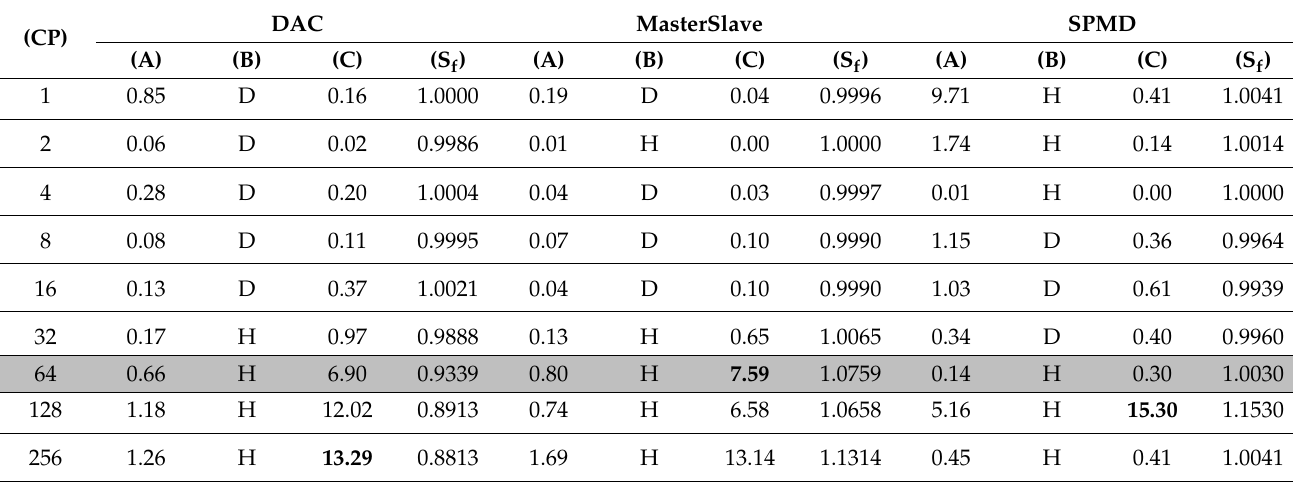
Table 8. Host and Docker comparison of median execution